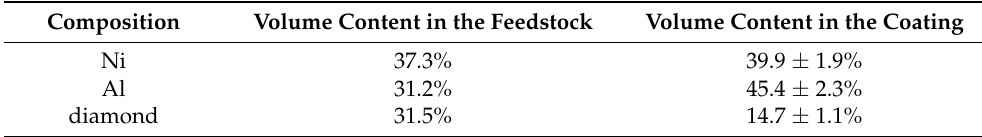
Table 3. Ni, Al, and diamond content in the coating analyzed by ImageJ software.